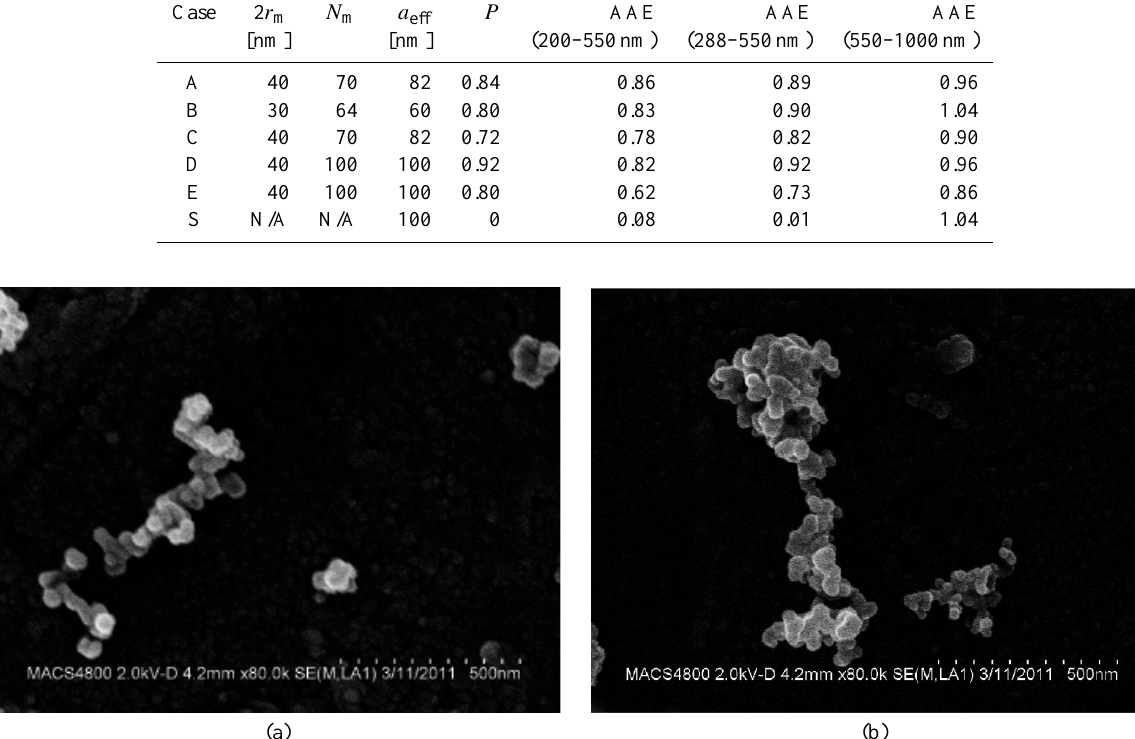
Fig. 1. Two SEM images of bare BC aggregates. In each image, two types of morphologies are evident: chain-like (lacy) structures and compact